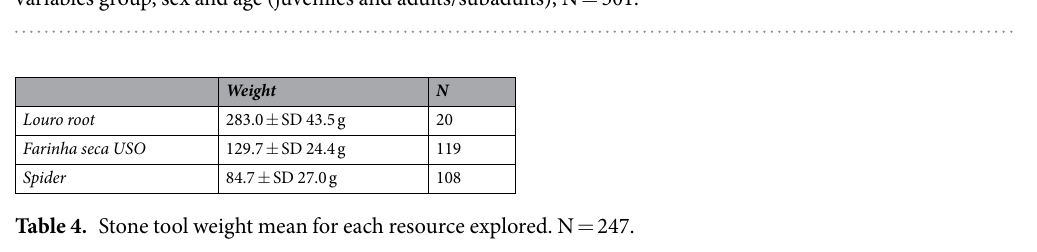
Table 3. GLMM results for the stone dimensions (weight, length, width and thickness) and the predictor variables group, sex and age (juveniles and adults/subadults), N = 301.